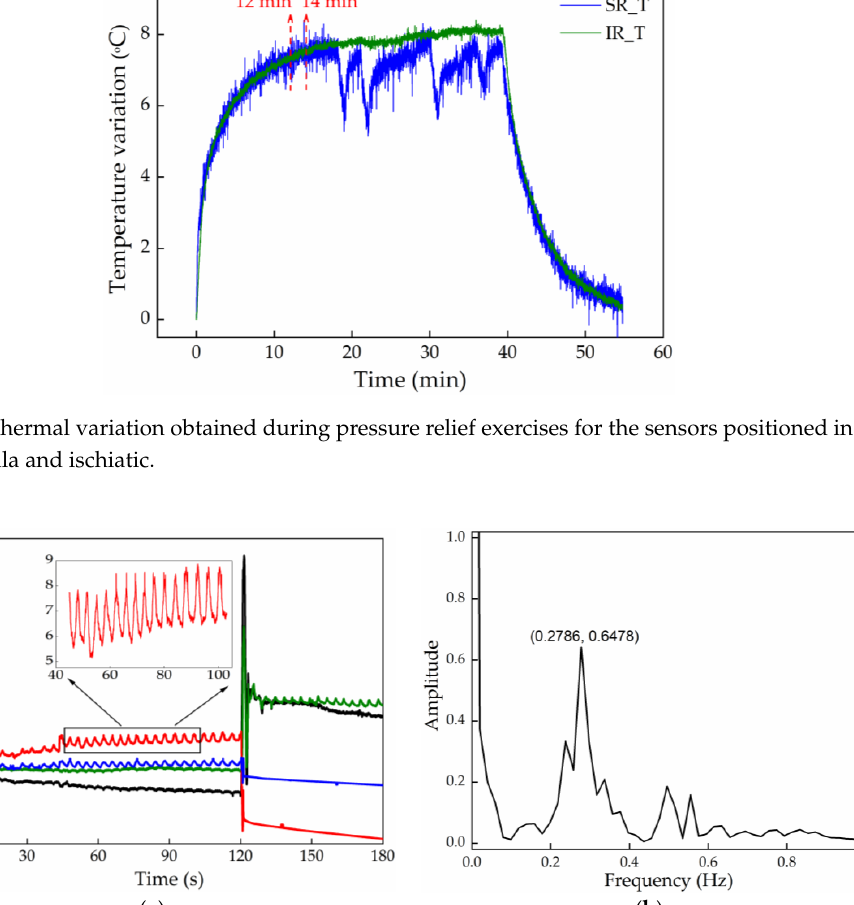
Figure 7. Thermal variation obtained during pressure relief exercises for the sensors positioned in the right scapula and ischiatic.